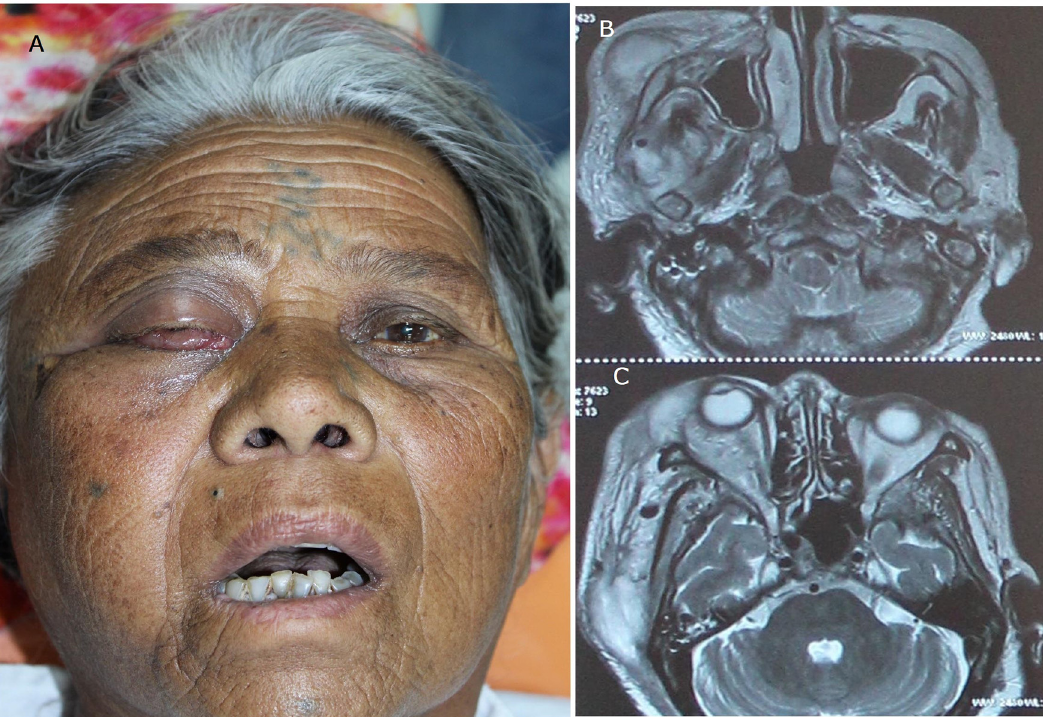
Fig. 2. Facial swelling on right side with right orbital cellulits (A), MRI showing swelling & proptosis of the right eye globe and ill-de fi ned radiopacities and diffuse fatty strands in the intraconal and extraconal compartment